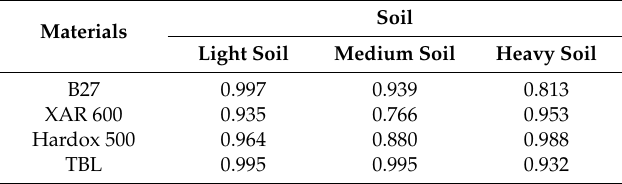
Table 7. Nash-Sutcli ff e coe ffi cient results for the tested steels in particular